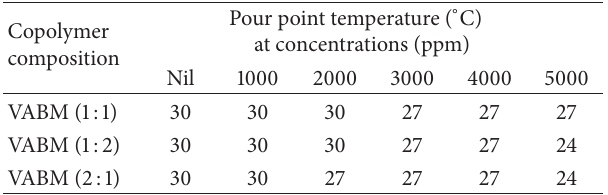
Table 5: The pour point of untreated crude oil and treated crude oil with